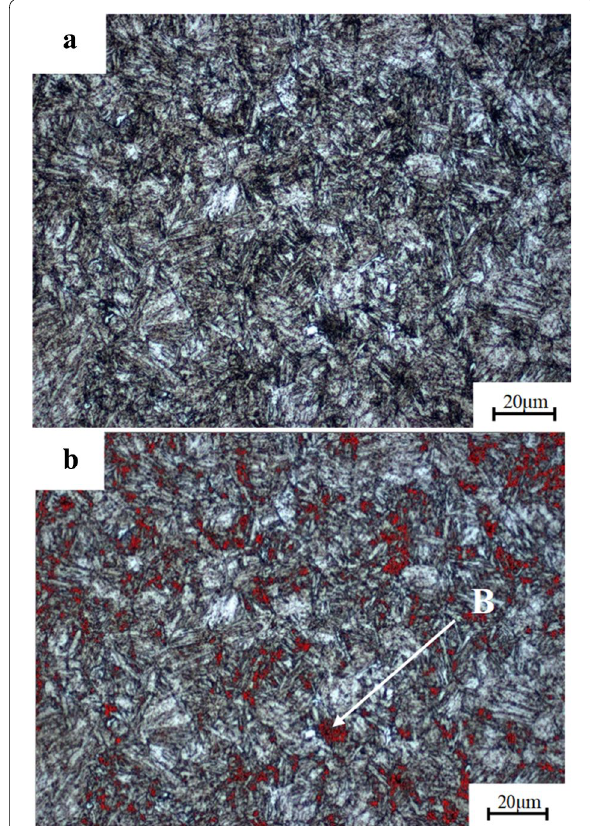
Figure 5 Bainite calibration when P T is 300 °C: a normal metallographic diagram; b calibrated